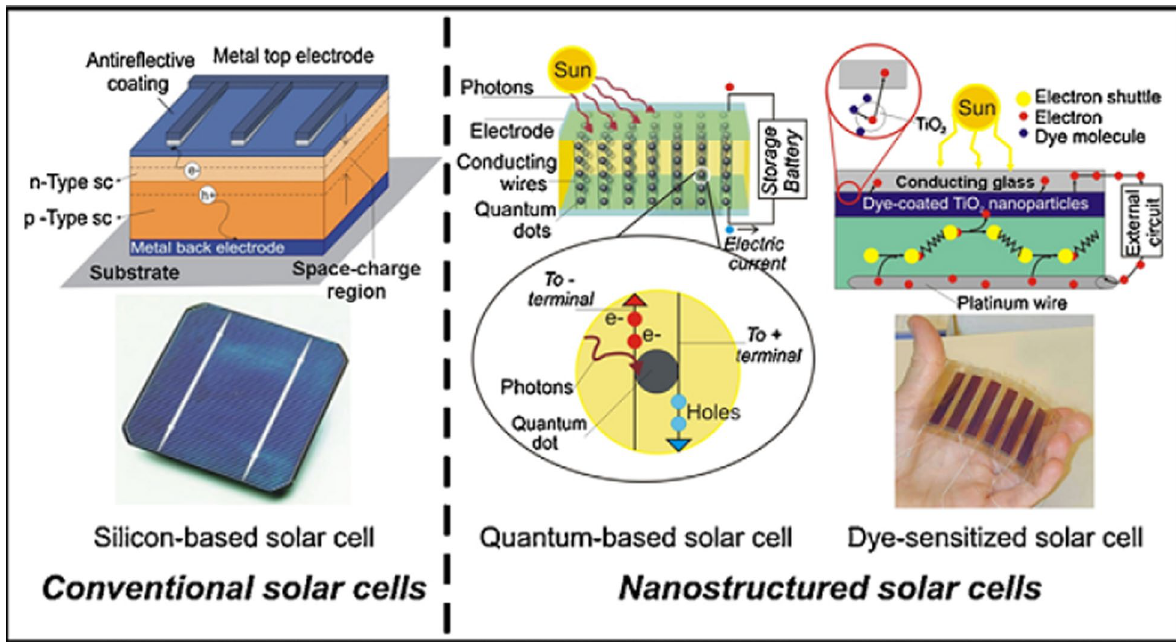
Fig. 5 Evolution of photovoltaic technology: from conventional (silicon-based solar cells) to nanostructured solar cells (quantum-based and dye-sensitized solar cells) (Sharma et al. 2018; https:// www. gamry. com/ appli cation- notes/ physe chem/ dssc- dye- sensi tized- solar- cells)